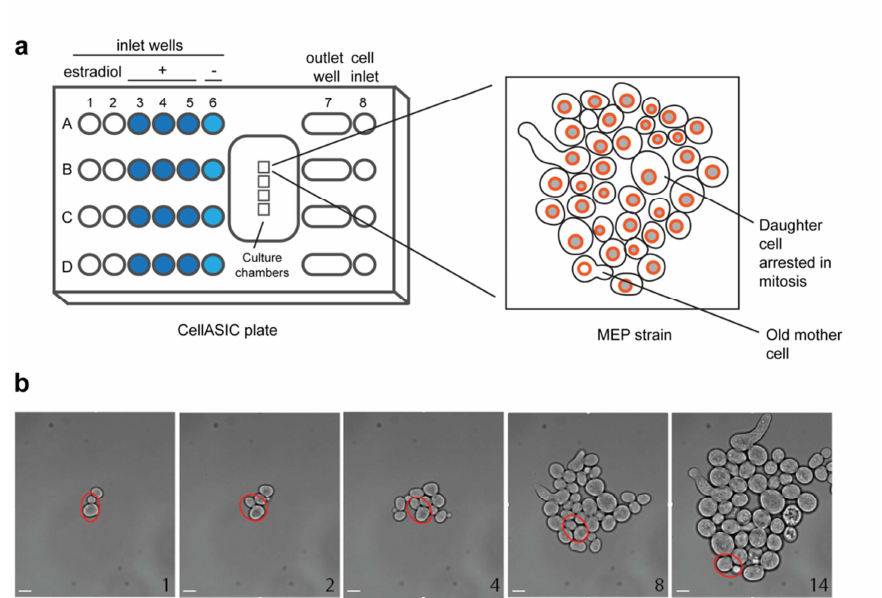
Figure 1: Design of a CellASIC-based platform to study replicative yeast aging. (a) Four strains (A-D) can be monitored for long periods using a CellASIC microfluidic system. Once cells are trapped in the culture cham- bers, perfusion of the media takes place for 60 min and perfusion of the media with estradiol is active for 34 h. After addition of estradiol, only the daughter cells of the MEP strain will be arrested in mitosis and cannot prolif- erate whereas the mother cell contin- ues dividing. Input wells 1 and 2 are not needed for these experiments and are left empty. (b) Bright-field images show the growth of a colony from a founder mother cell (circled in red). Scale bar, 5